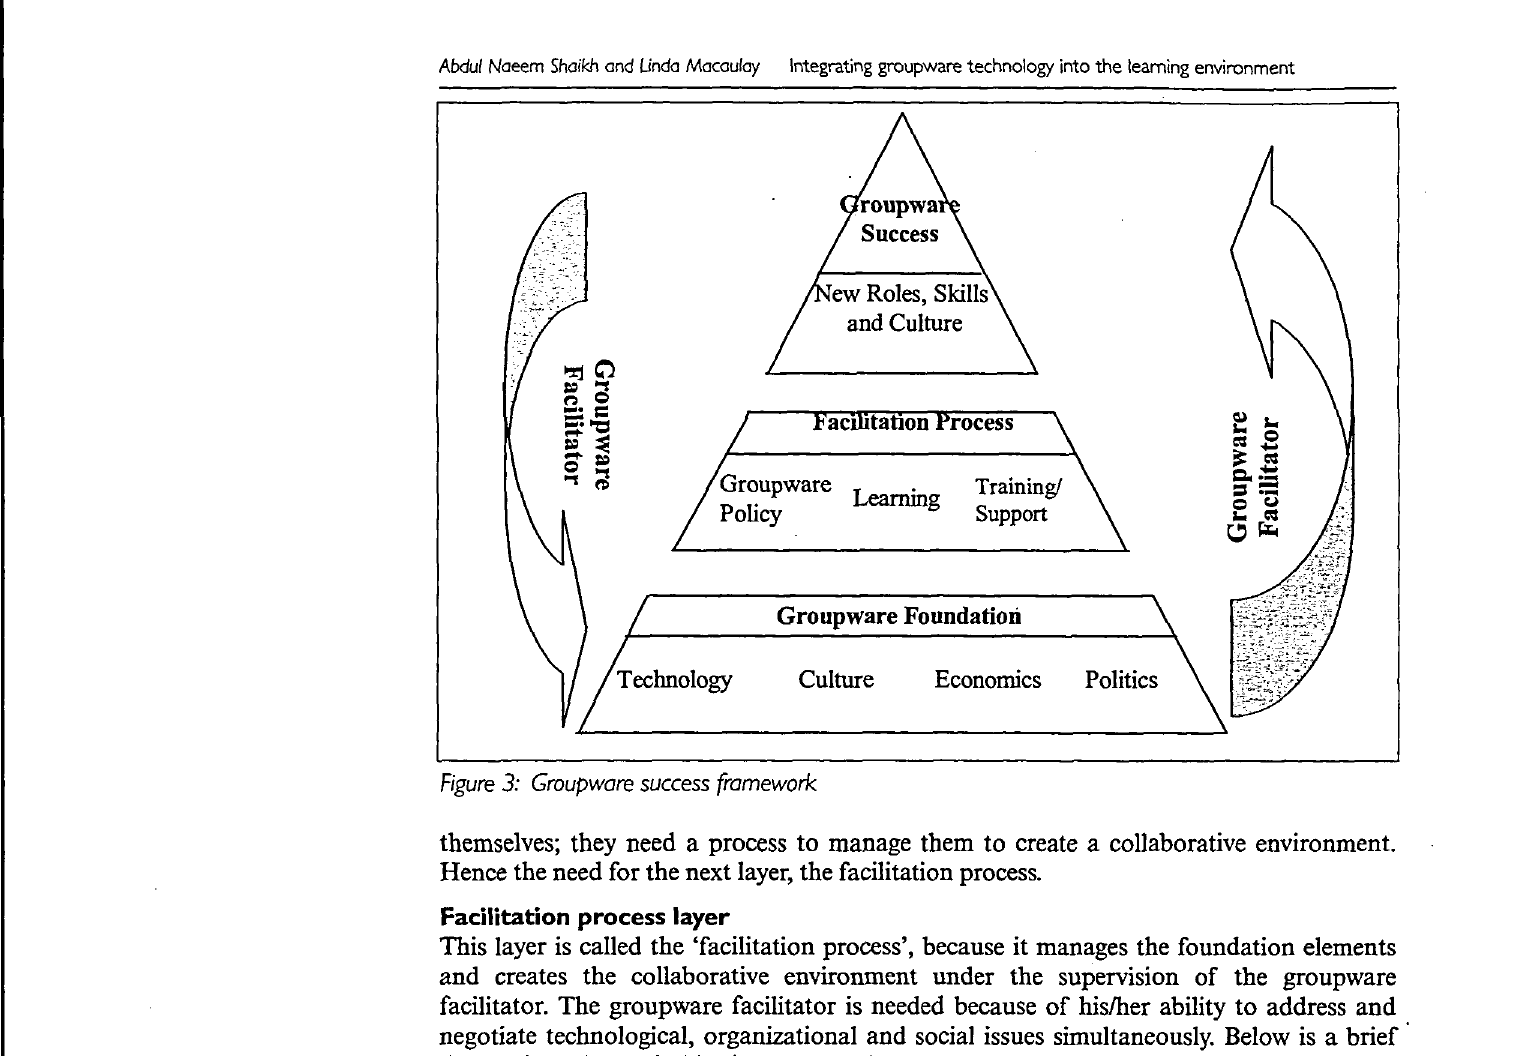
Figure 3: Groupware success